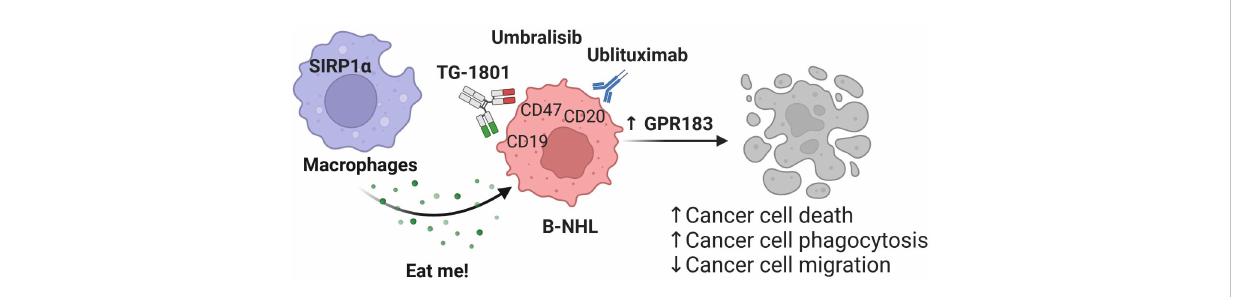
FIGURE 4 Mechanism of action of the TG-1801/U2 triplet combination therapy in BL. The novel CD47-CD19 bispeci fi c antibody potentiates the anti-tumour activity of the ublituximab-umbralisib regimen through activation of the pro-in fl ammatory GPR183, thus promoting macrophage-dependent phagocytosis, B-cell cytoskeleton remodelling and B-cell